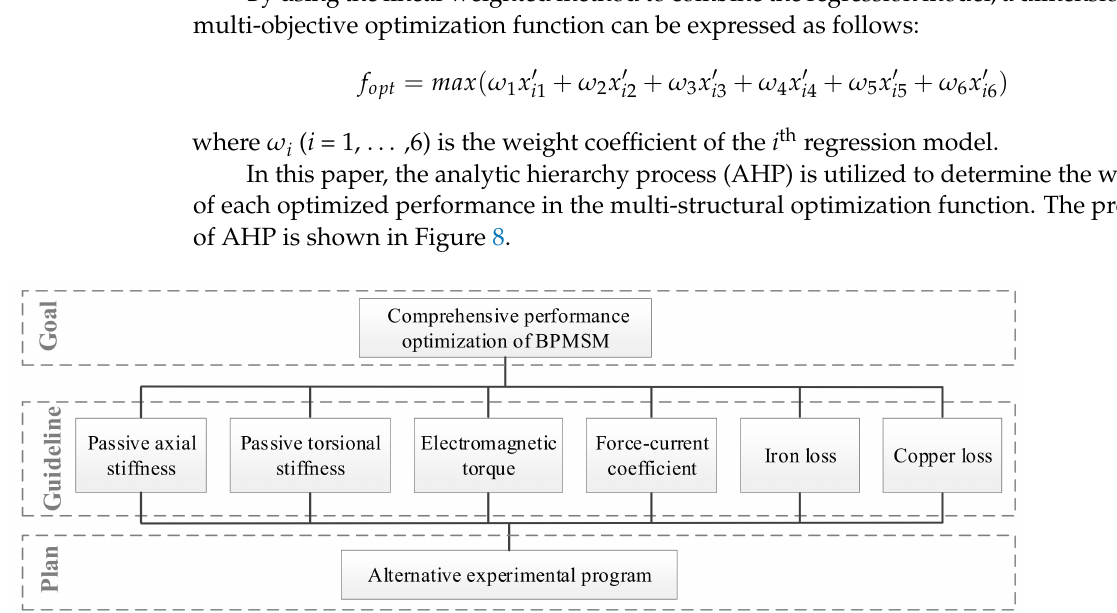
Figure 8. The AHP flowchart.